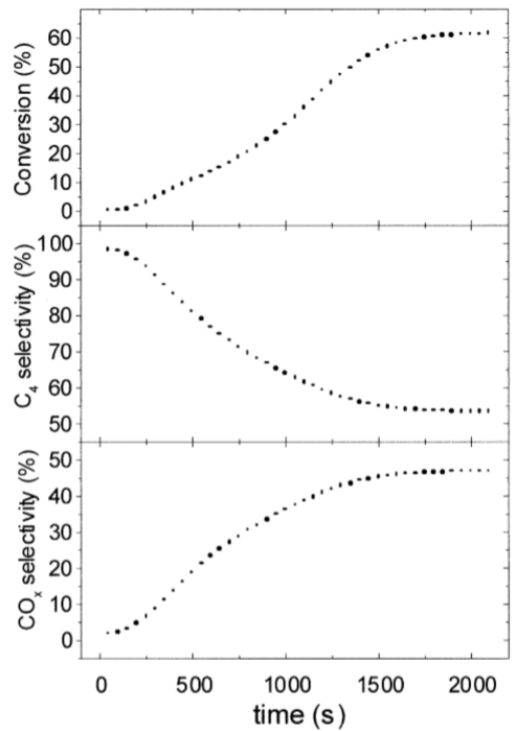
Figure 10. Butane conversion and product selectivity versus time, for an in situ redox fluidized bed reactor during oxidative dehydrogenation of n-butane on V/MgO catalyst. The conversion of butane increases in the first half an hour until a steady state is reached. The selectivity to C 4 is high in the beginning, but later decreases when the CO x is formed. (Reprinted with permission from [54]. Copyright 2001 Elsevier).